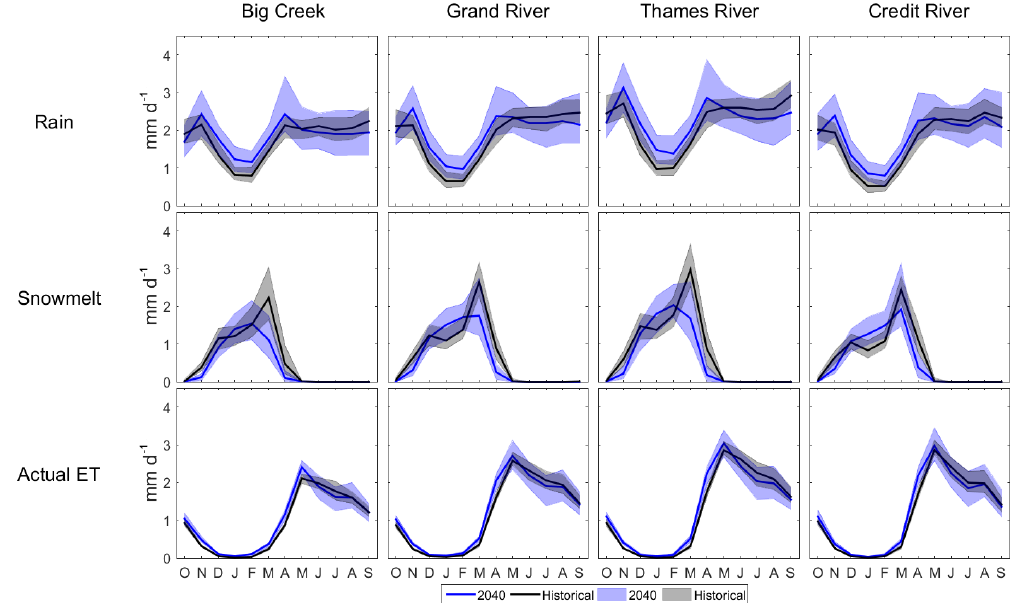
Figure 4. A 50-member range, average rain, snowmelt and actual ET amounts for the historical and the 2040s